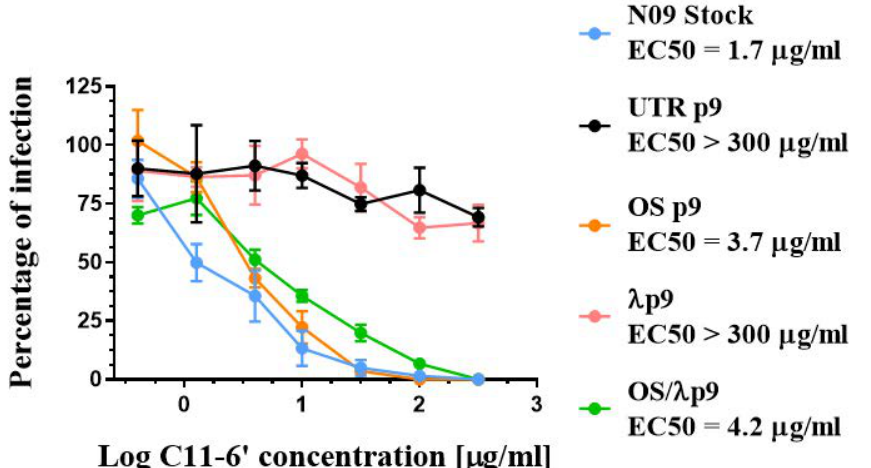
Figure 6. Dose–response curves demonstrating the antiviral activity of C11-6 (cid:48) when pre-incubated with A(H1N1)pdm09 variants before infection in MDCK cells. OS p9 = virus passaged nine times in the presence of OS alone; λ p9 = virus passaged nine times in the presence of IFN λ 1 alone; OS/ λ p9 = virus passaged nine times in the presence of OS plus IFN λ 1; UTR p9 = virus passaged nine times in the absence of selective drug pressure; N09 Stock = virus produced in MDCK cells and never passaged in Calu-3. Mean EC50 values and standard deviations were calculated from two independent experiments performed in